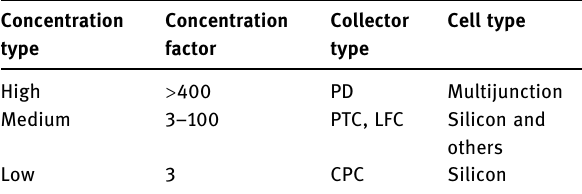
Table 11: Characteristics of concentrating photovoltaic applications Concentration